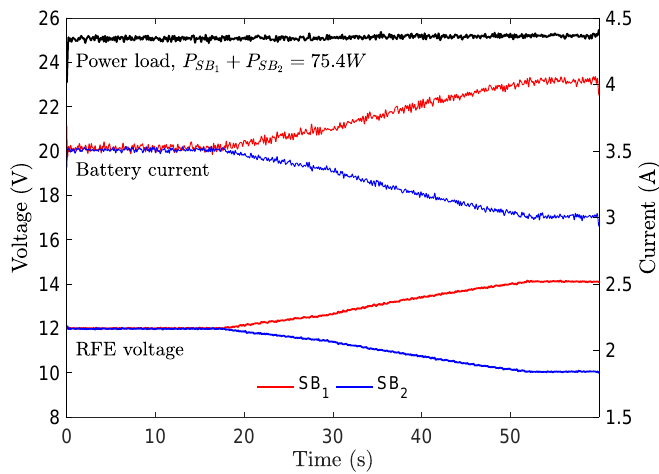
Figure 11. Experimental bench test results—active battery discharging.